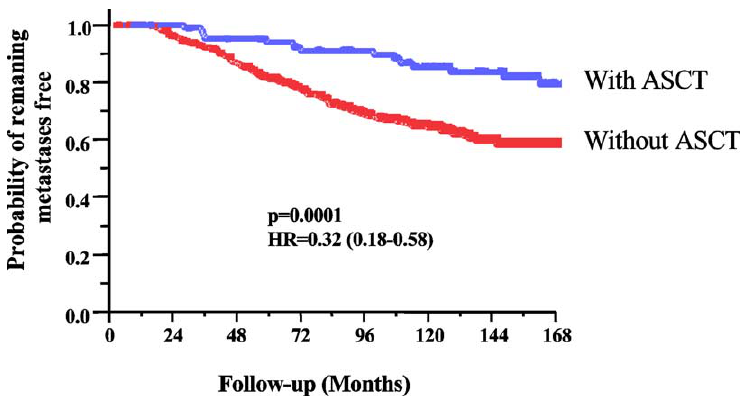
Fig. 2. Survival curves of MAI (cid:1) 3 in node negative invasive breast cancer patients < 55 years with and without adjuvant